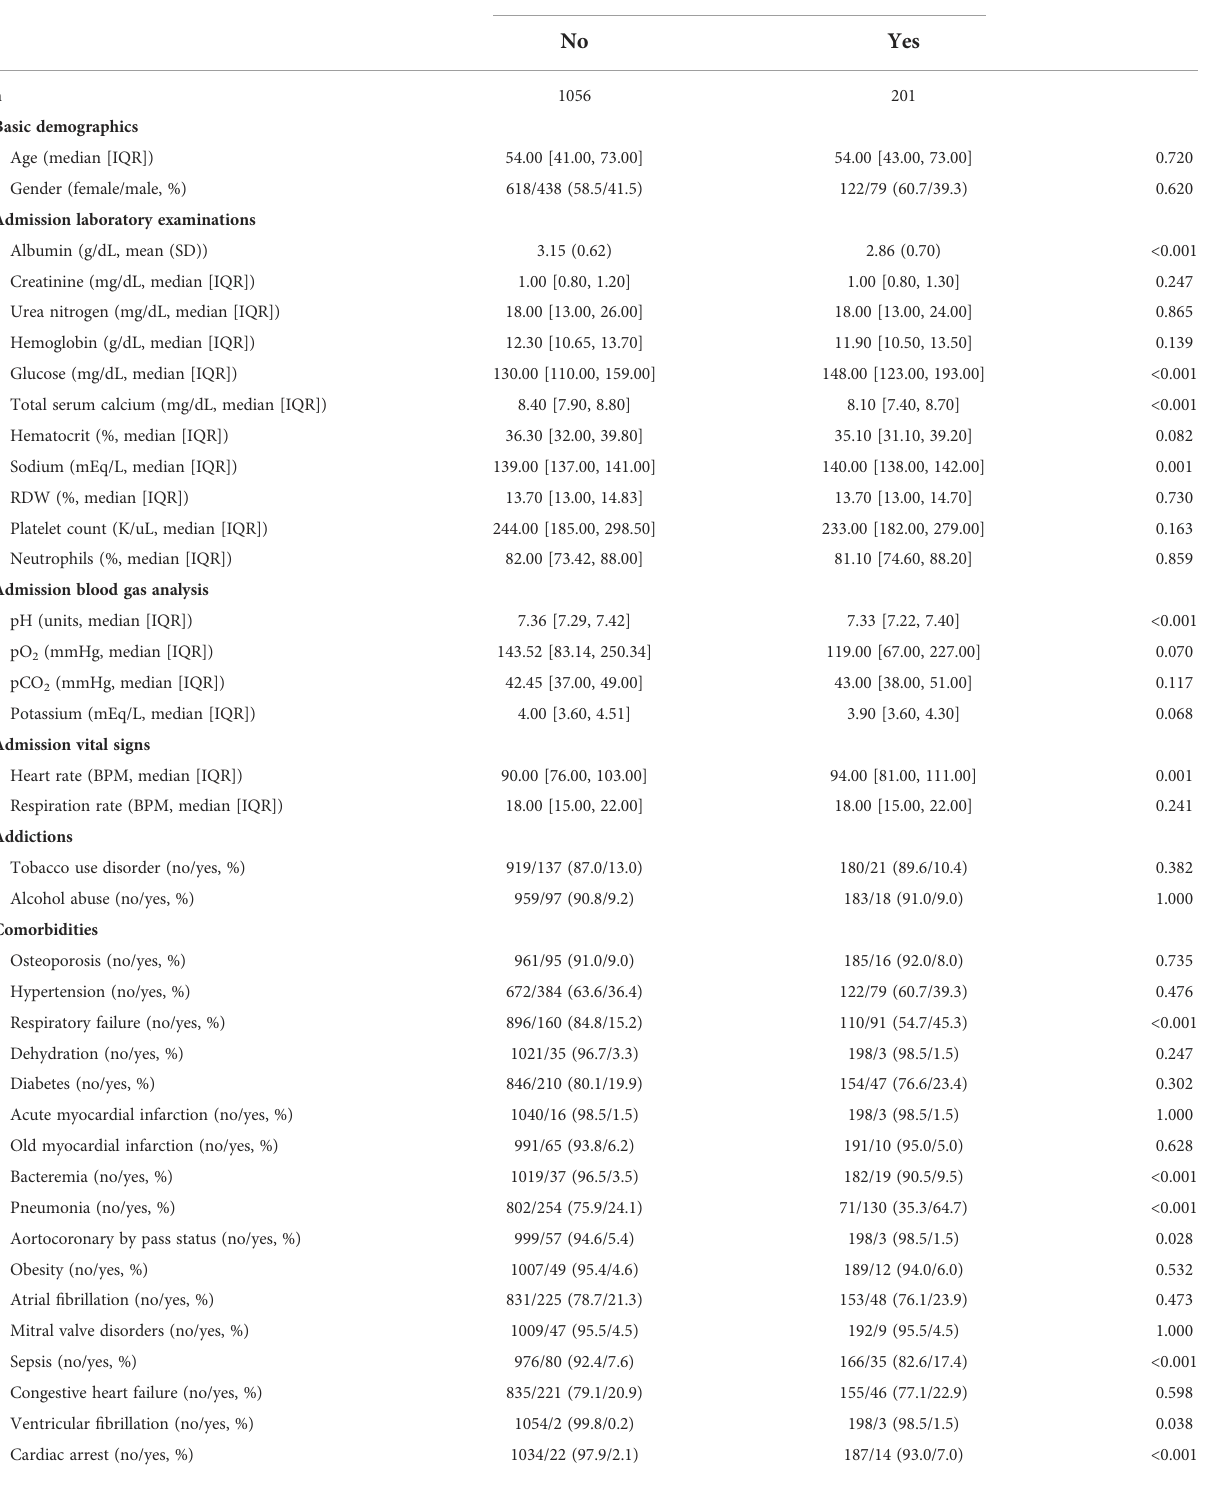
TABLE 2 A comparison of clinical characteristics between patients with and without persistent critical